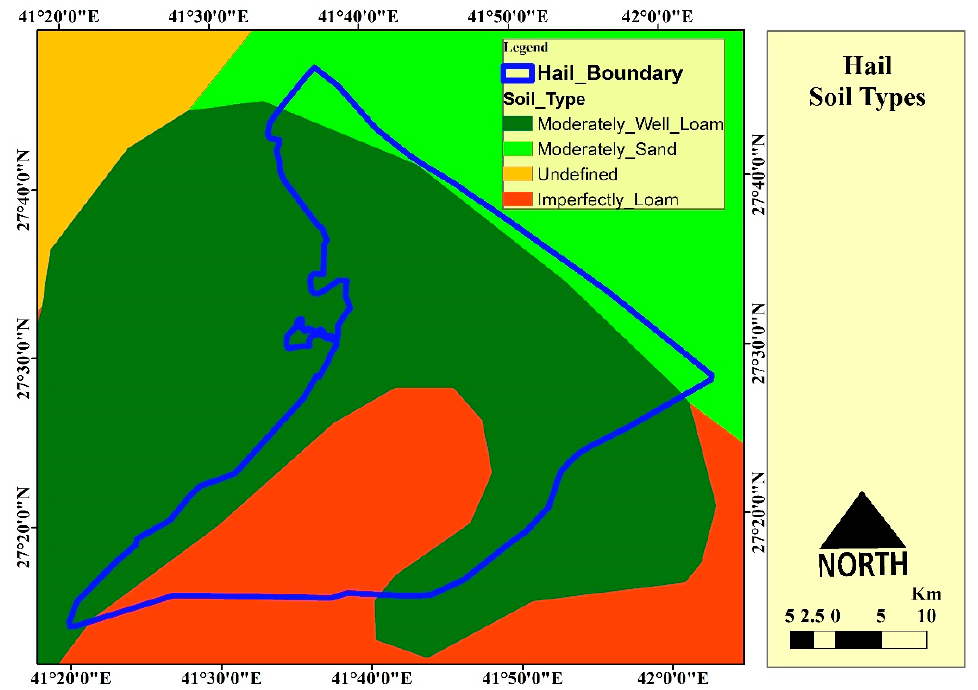
Figure 4. Soil type map for Hail city.